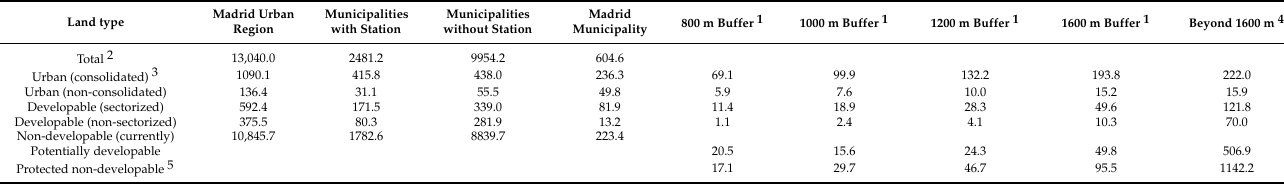
Table 7. Amount of land types (km 2 ) in the municipalities of the Madrid urban region and